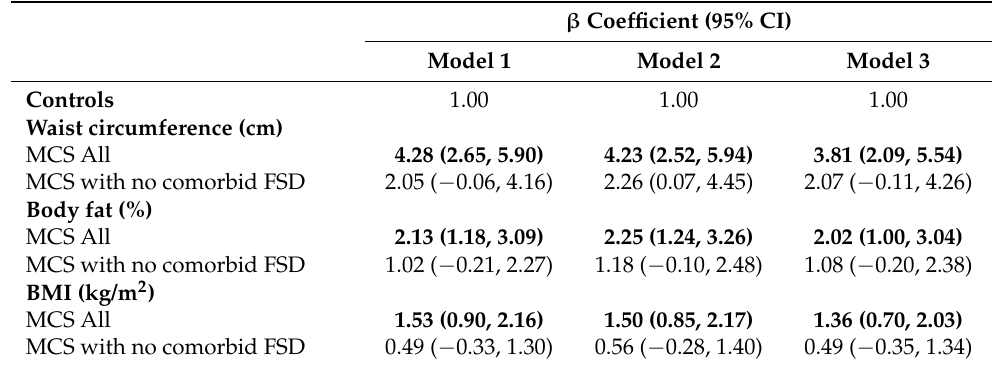
Table 2. Association between anthropometry measures and MCS case status compared to